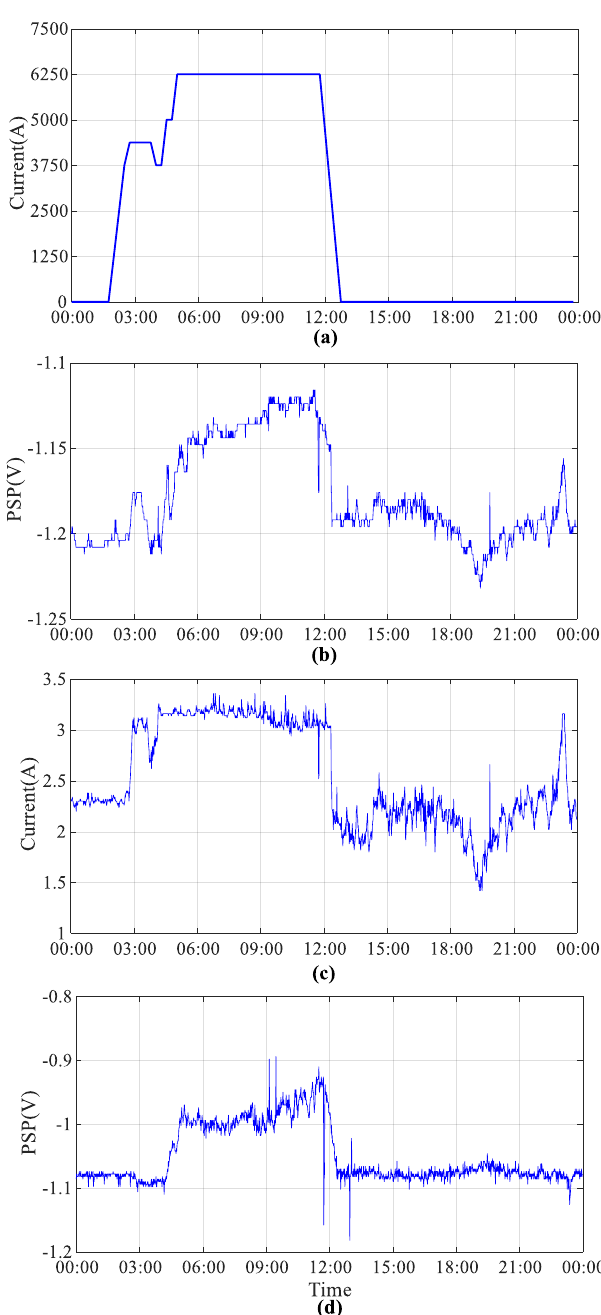
Figure 3. Monitoring data during the commissioning of the Zhaqing project on 24 December 2017: ( a ) Grounding current of the Gaoqing electrode; ( b ) PSP of the Xiligu site; ( c ) stray current of the Changyi site; ( d ) PSP of the Changyi site.